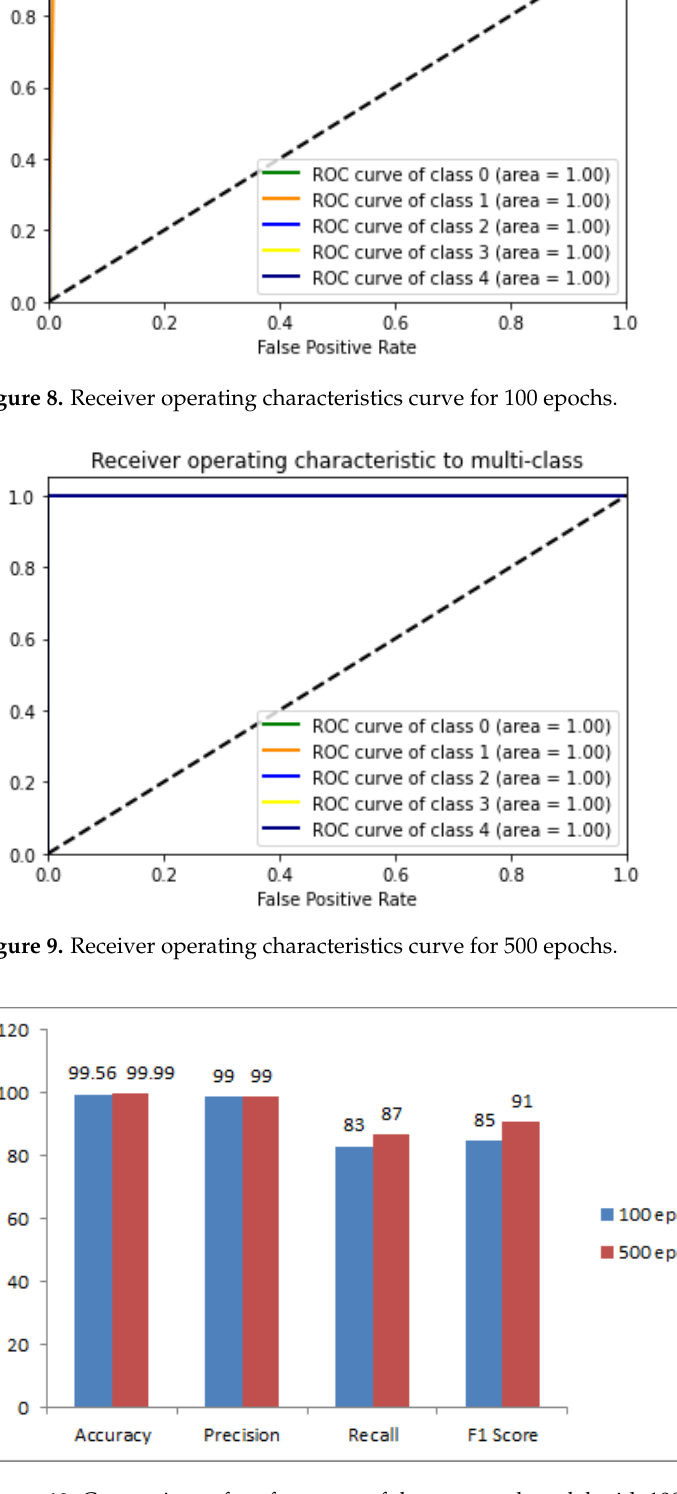
Figure 10. Comparison of performance of the proposed model with 100 and 500 epochs.